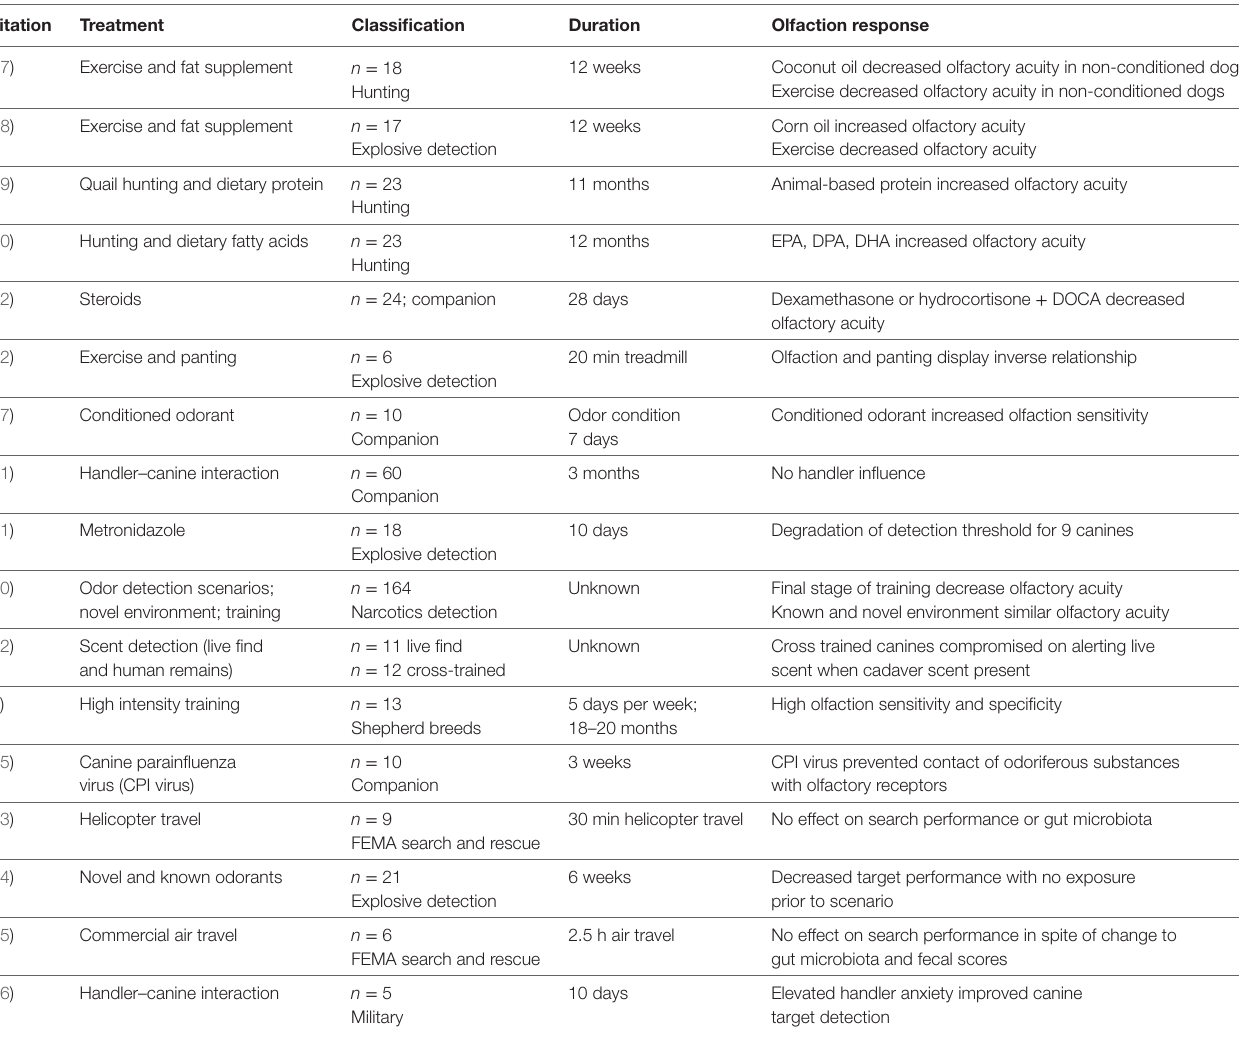
TABLe 2 | Summary of selected studies reporting effects on olfaction/performance associated with management or medical